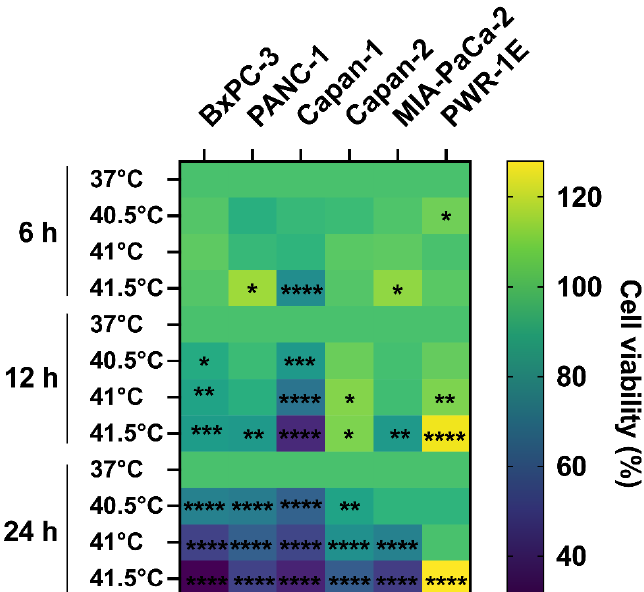
Figure 2. Effect of hyperthermia on pancreatic cancer cells. Heatmap showing the effect of hyperthermia on different cell lines for different durations (6, 12, and 24 h) and different temperatures (37 ◦ C = control, 40.5-, 41-, and 41.5 ◦ C). The color legend shows the percentage of relative cell survival compared to controls. There is a general trend of increased cell death with increased temperature and time of exposure. The healthy control cells are not killed by hyperthermia treatment. Results were expressed as relative cell viability as compared to 37 ◦ C. Statistical significance * p < 0.05; ** p < 0.001; *** p < 0.0001; **** p < 0.00001.